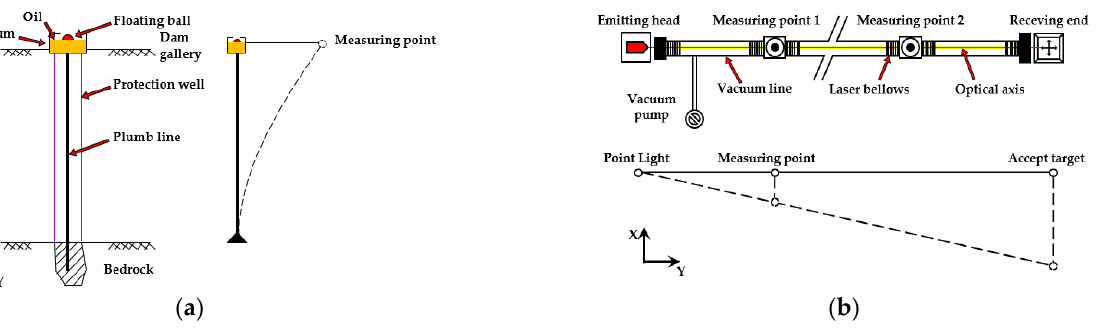
Figure 8. Instrument schematic of the dam deformation monitoring system (X-direction, Y-direction represent the direction along the river and the direction perpendicular to the river, respectively). ( a ) Inverted plumb line, ( b ) Vacuum laser.